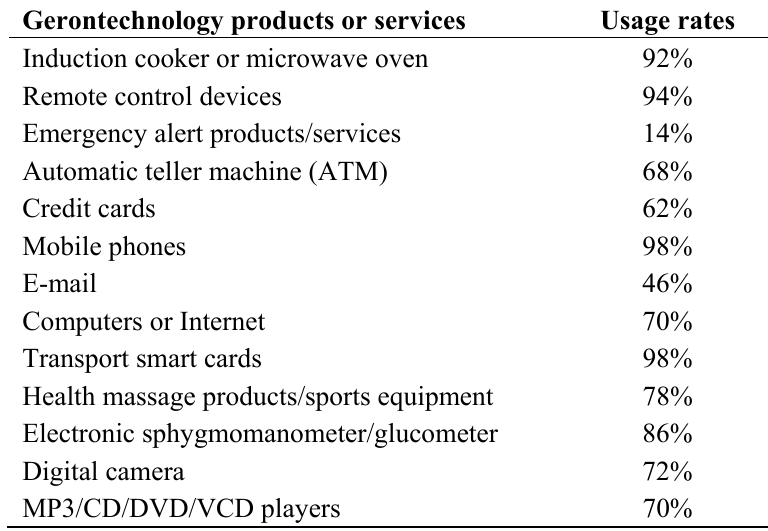
Table 2. Background information about technology use.